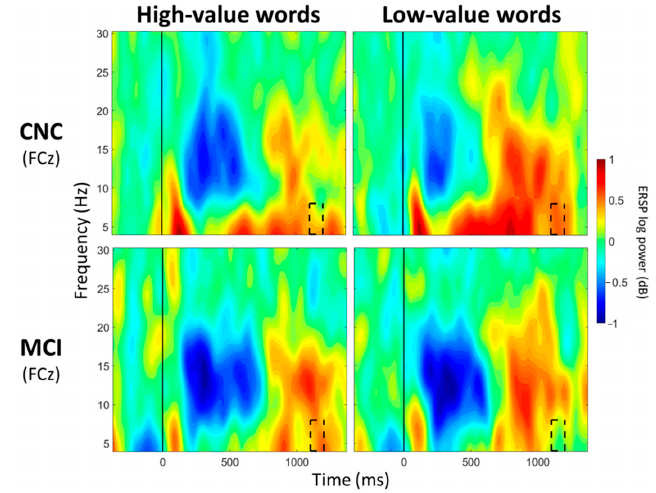
Figure 5. ERSP Comparisons for Theta Band for Interaction Effects Between Group and Value. Spectrograms illustrate differences between groups (CNC/MCI) and value (high-/low-value) for theta band (4–8 Hz) at FCz. The 0 ms time point (solid vertical line) represents stimulus onset. Dashed black rectangles indicate the time windows in which significant interaction effects between group and value were observed (also see Table 5). CNC: Cognitively normal older controls; MCI: mild cognitive impairment.